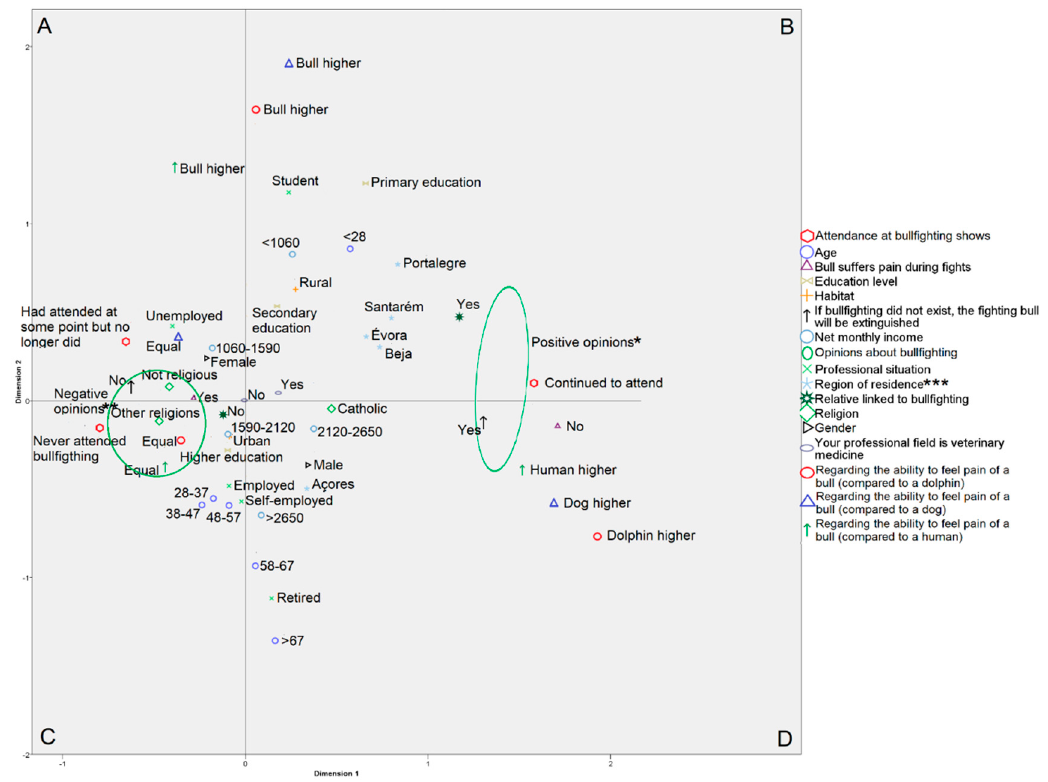
Figure 1. Multiple correspondence analysis for the different demographic and opinion variables. Variables with a similar profile tend to be grouped together whereas those negatively correlated are positioned on diagonally opposite sides of the graph. The origin of the graph reflects the weighted average for each demographic or opinion variable considered. The closer a variable is to the origin, the closer it is to the average profile of the survey respondents. * Positive opinions: location of the category points “Yes” for the questions “Bullfighting favors economy”, “Bullfighting favors tourism”, “Bullfighting favors economy”, “Bullfighting must receive public founds”, “Bullfighting generates positive connotations for the country” and “Bullfighting continuity should be allowed” and the category points “Bullfighting higher” and “Equal” for the question “Bullfighting has greater, less or equal artistic value than painting”. ** Negative opinions: location of the category points “No” and “Painting higher” for the same questions. *** Only the districts with opinions more favorable to bullfighting are shown. The rest are located in or near quadrants A and C .